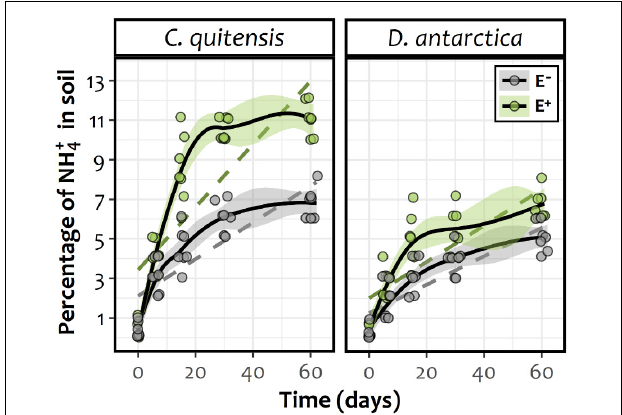
FIGURE 2 | Temporal smooth functions (solid lines) and their approximate 95% confidence intervals (shaded area) for E − (gray) and E+ (green) individuals of either Antarctic vascular plant species Colobanthus quitensis or Deschampsia antarctica , as derived from a GAMM fitted model. Confidence interval overlapping can be considered to dilute any significant difference between splines during the respective time. As a reference, dashed lines represent the simplest (i.e., linear) model fit for each experimental group. The respective coefficients were, for C. quitensis : slope E − = 0.093, SE E − = 0.015, df E − = 66; slope E+ = 0.161, SE E+ = 0.016, df E+ = 66 and for D. antarctica : slope E − = 0.071, SE E − = 0.009, df E − = 66; slope E+ = 0.091, SE E+ = 0.010, df E+ = 66. All linear regression slopes were statistically different from zero (data not